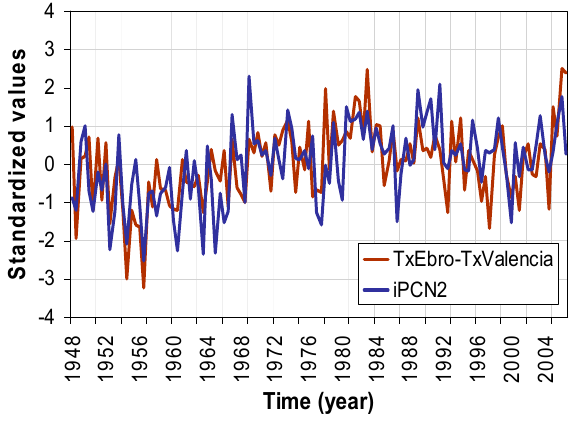
Figure 5. Time series of TxEbro-TxValencia (brown) and iPCN2 (blue).